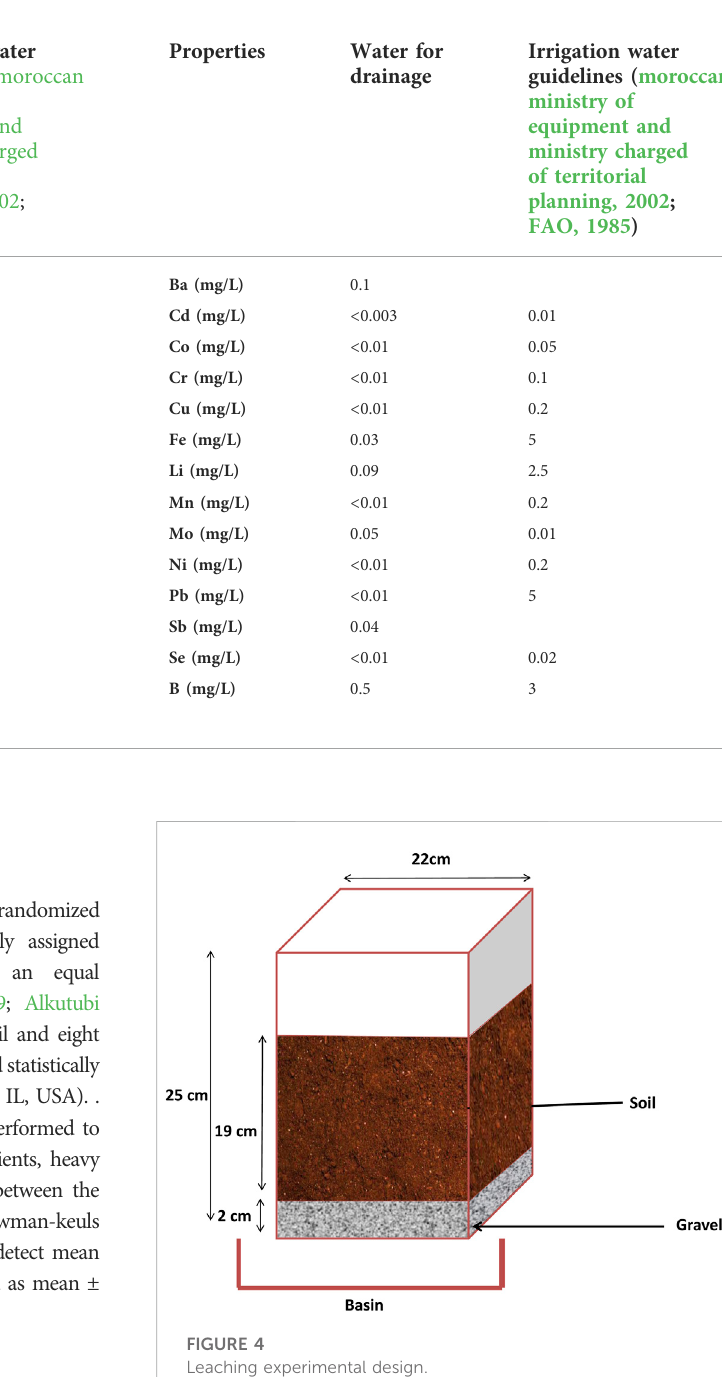
FIGURE 4 Leaching experimental